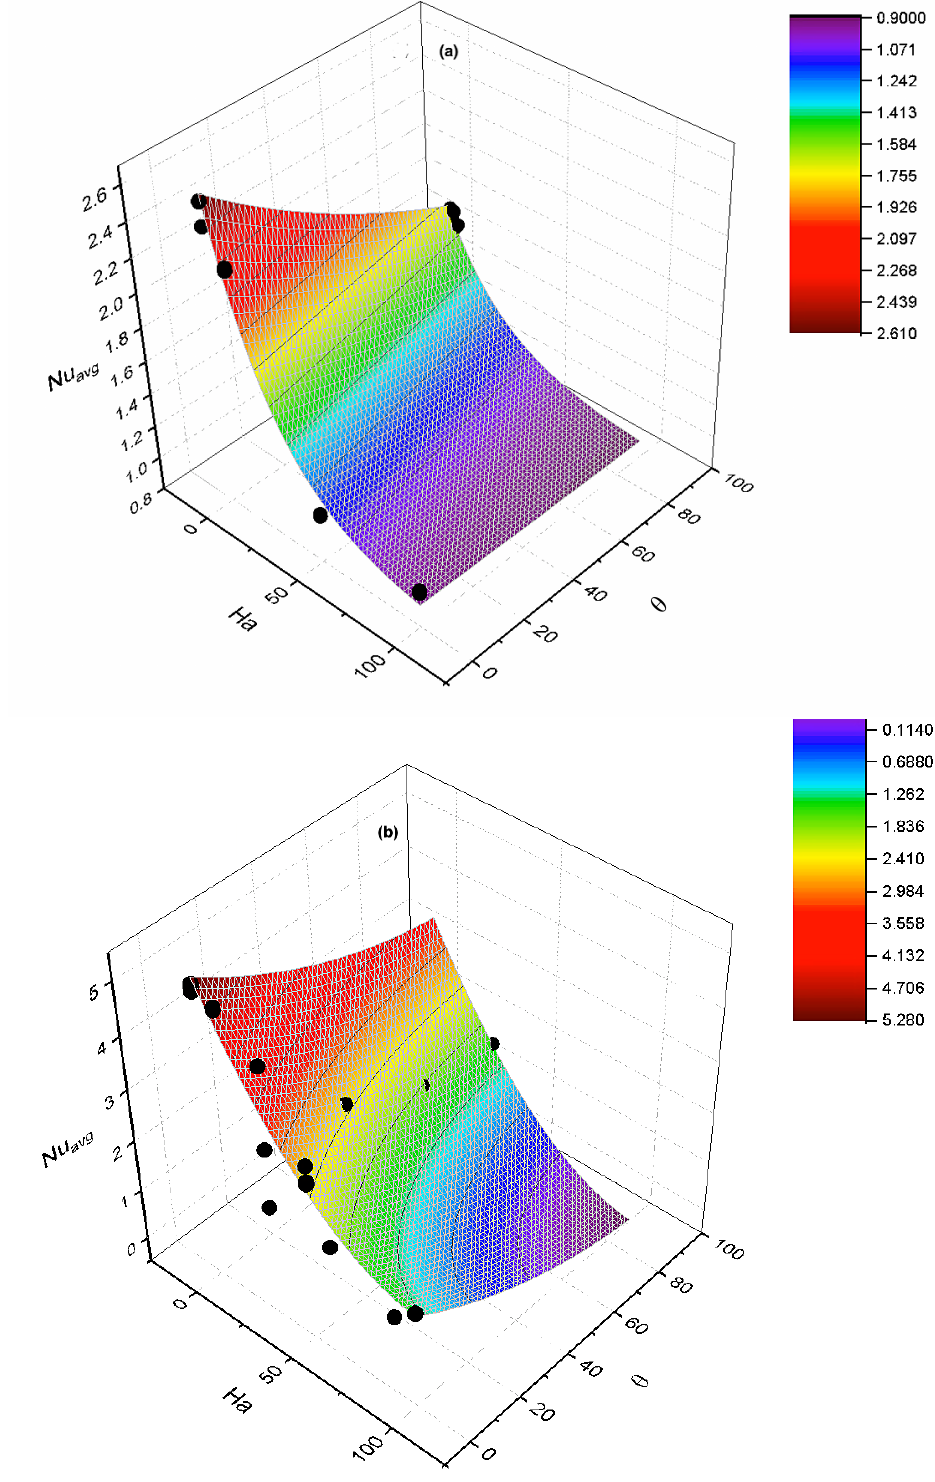
Figure 5. Development of correlation through fitting surfaces for ( a ) Ra = 10 4 , and ( b ) Ra = 10 5 under the influence of external magnetic field at different inclination angles for electrically conducting